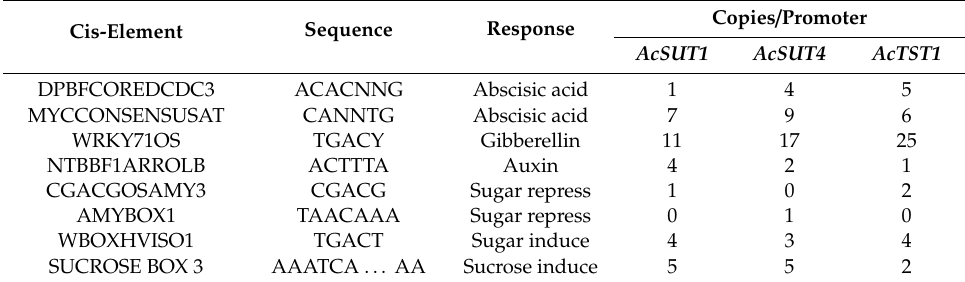
Figure 8. Expression patterns of AcSWEETs during kiwifruit ripening. The stages were 0, 2, 4, 6, 8, 10, and 12 DAH. The error bars represent the means ± standard deviation from three independent biological replicates. The bars with the same letter are not significantly different at the 0.01 level according to the student’s t -test. The expression level of the first member in each figure at 0 DAH was set to ‘1’. Table 1. Putative cis -elements located in the promoter regions of the AcSUT1 , AcSUT4 , and AcTST1 genes.